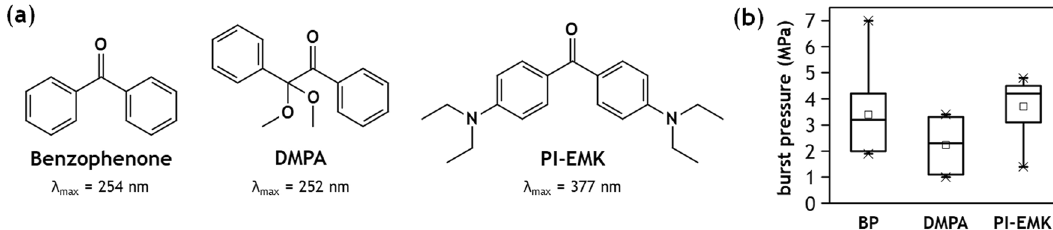
Figure 4. Comparison of photoinitiator performance. ( a ) Chemical structure of photoinitiators with the maximum absorption wavelength, and ( b ) burst pressure measured across a 10 µ m-thick barrier, printed on surfaces treated with the same mol% of each photoinitiator equivalent to 1.0 wt% BP (n ≥ 6 for all